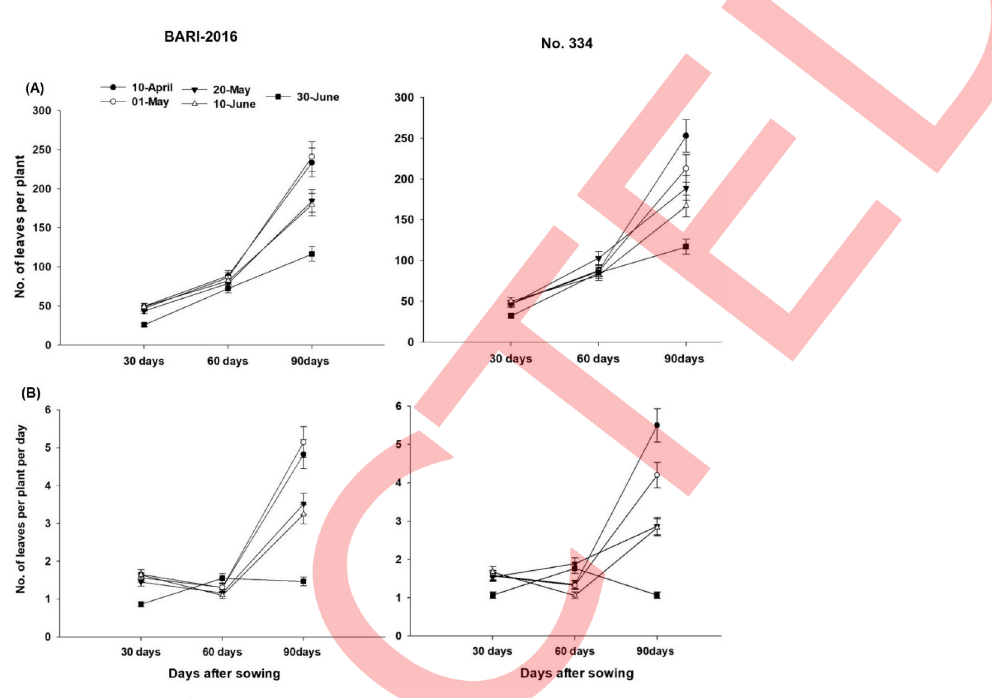
Fig 1. Effect of sowing date and genotype on A) number of leaves per plant and B) increase in number of leaves per plant per day. Each value is average of two years and three replications (n = 6).